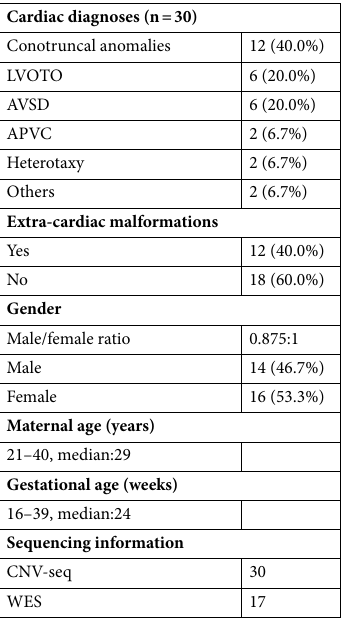
Table 1. General information of the entire cohort. APVC anomalous pulmonary venous connection, AVSD atrioventricular septal defect, CNV-seq copy-number variation sequencing, LVOTO left ventricular outflow tract obstruction, WES whole-exome sequencing.